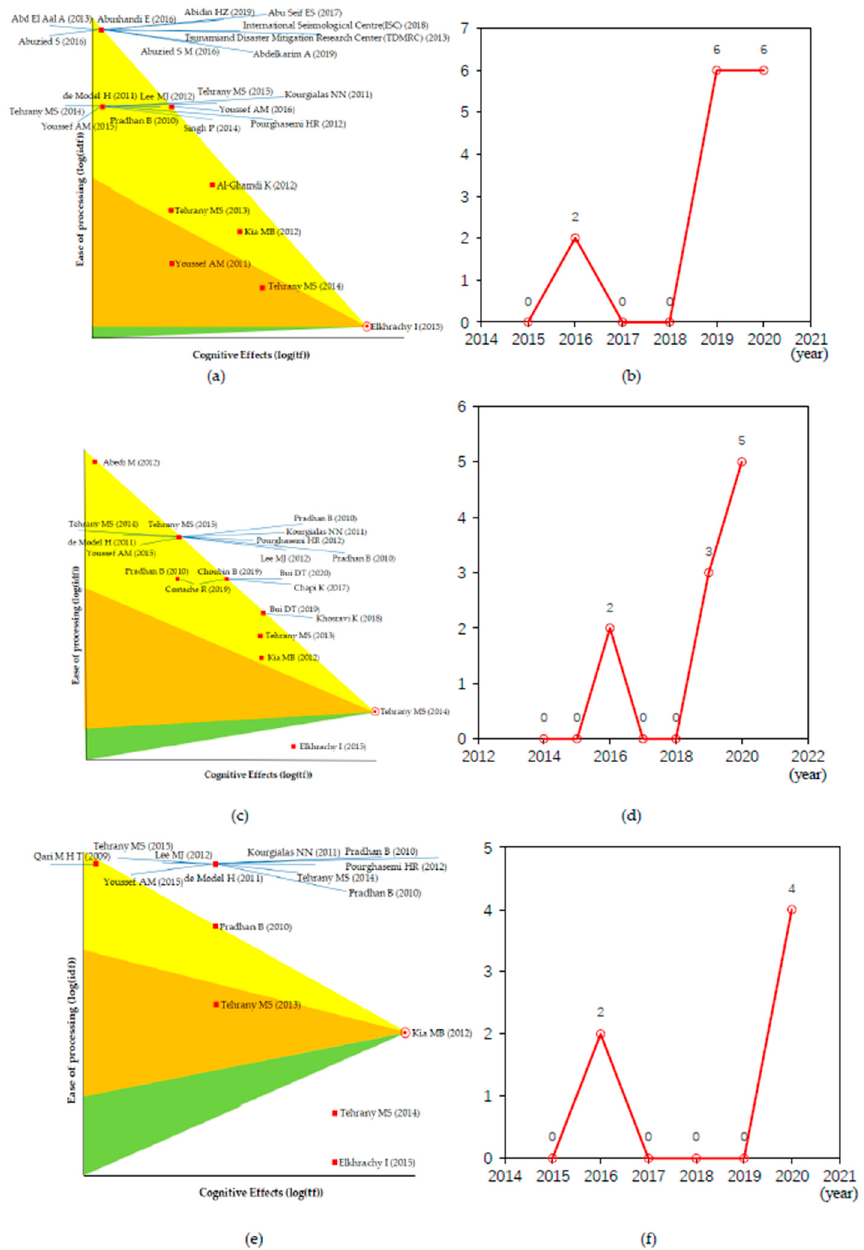
Figure 8. Co-citation status of four representative articles in the #6 flood susceptibility map in the timeline view. ( a , c , e ) are the pennant diagrams of Elkhrachy et al. [1], Tehrany et al. [80], and Kia et al. [64], respectively, which can be used to view the information for the refer-ences directly connected to a node. ( b , d , f ) show the time trends, respectively, and show the num-ber of times that Elkhrachy et al. [1], Tehrany et al. [80], and Kia et al. [64] were